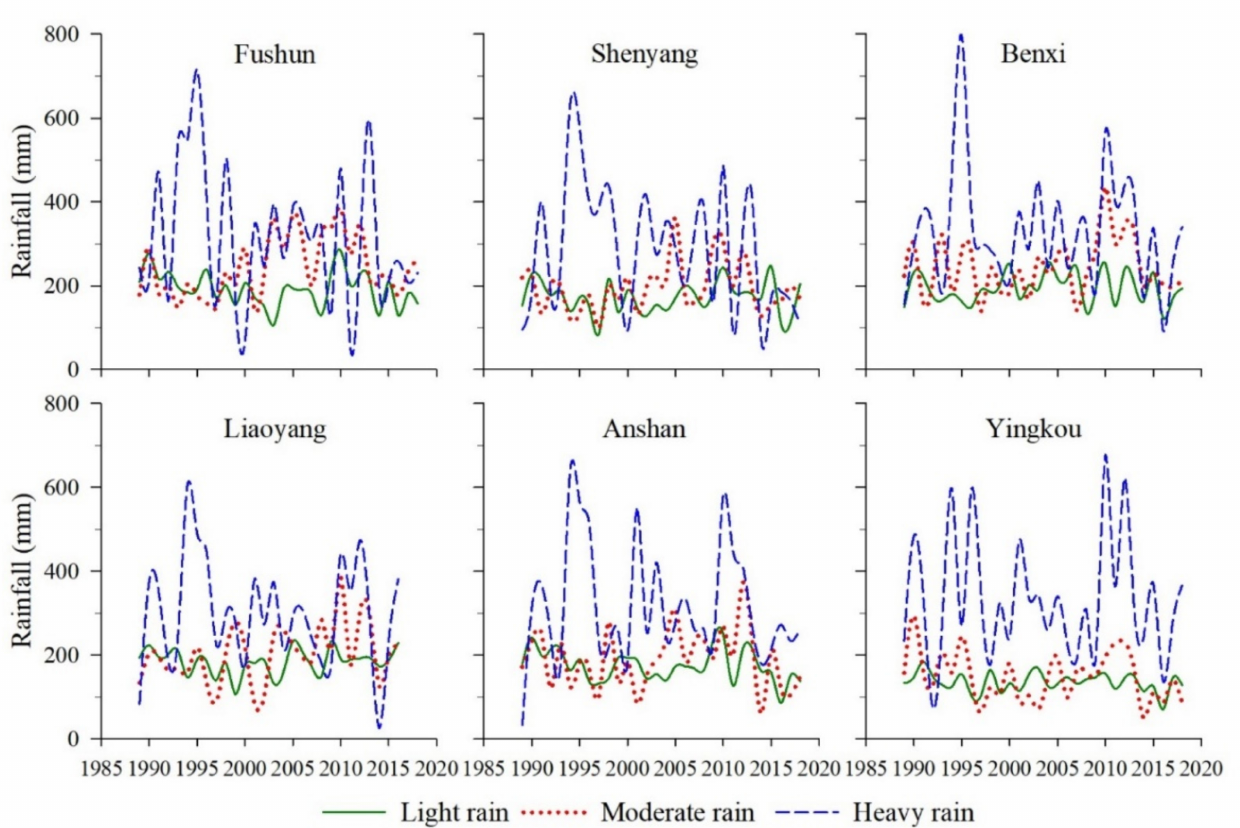
Figure 4. The average annual precipitation of the different rain intensities of the six cities during